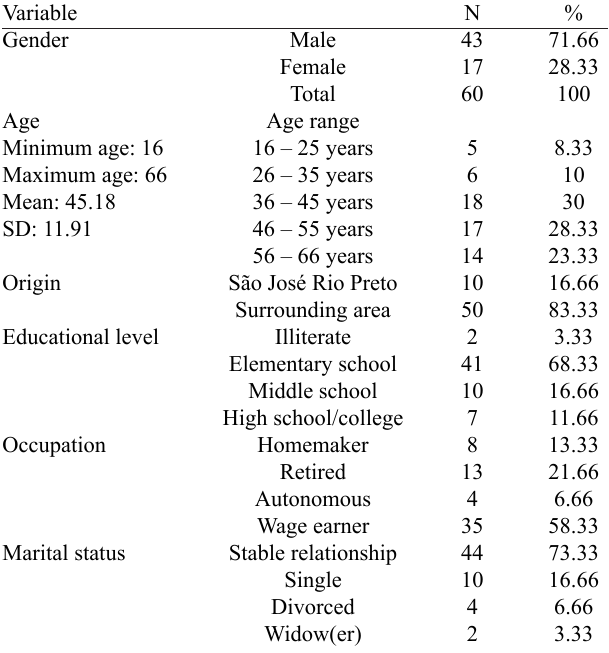
3. Comparison of Quality of Life (SF-36) scores between male and female heart transplantation